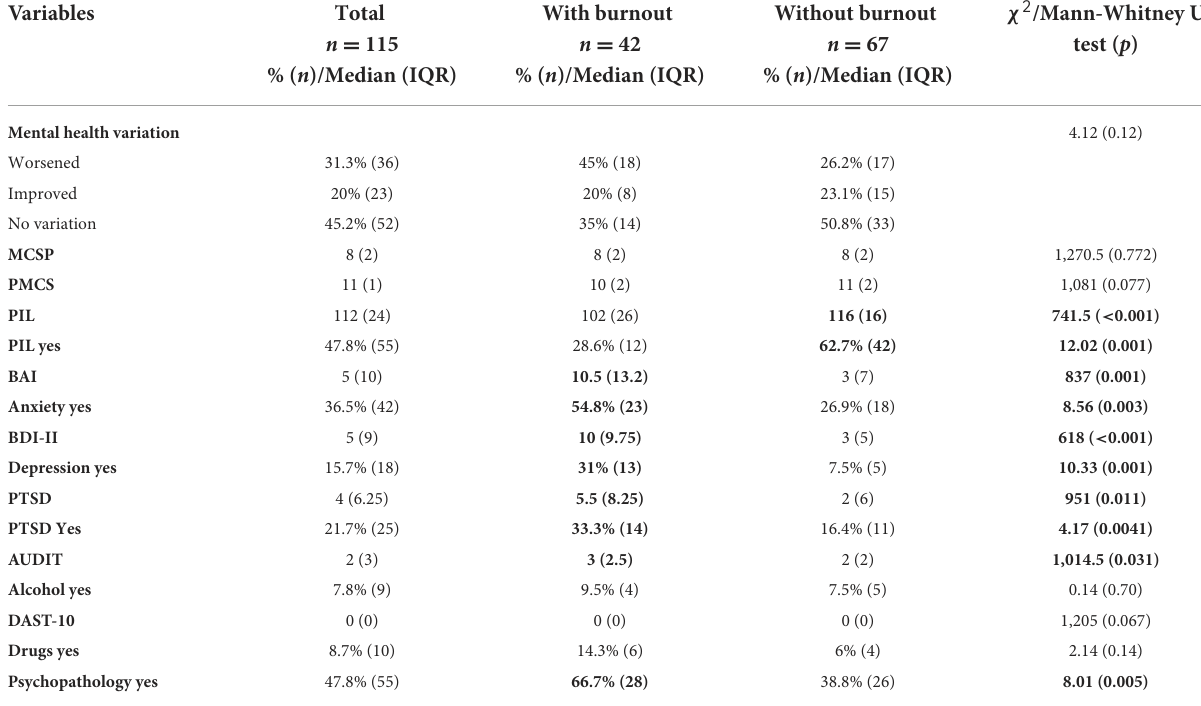
TABLE 2 Scores for moral courage, purpose in life, and psychopathological variables according to the presence of burnout and differences between the cohort groups. Variables